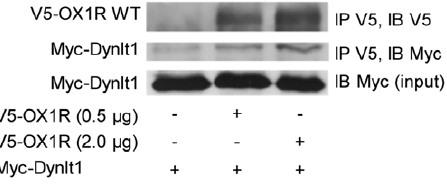
region of Dynlt3 (a.a. G92 to L116) by the one of Dynlt1 (a.a. G91 to I113) did not increase the ability of Dynlt3 to interact with orexin receptor CTDs (data not shown). Therefore, at least one other domain of dynein light chains confers selectivity towards cargo